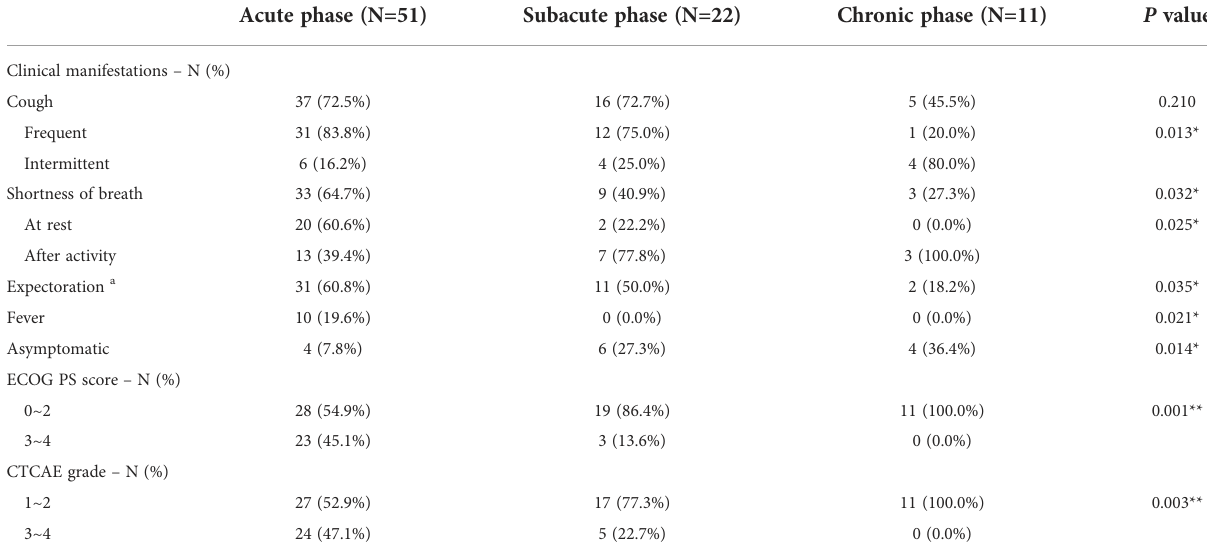
TABLE 2 Clinical features of patients in different